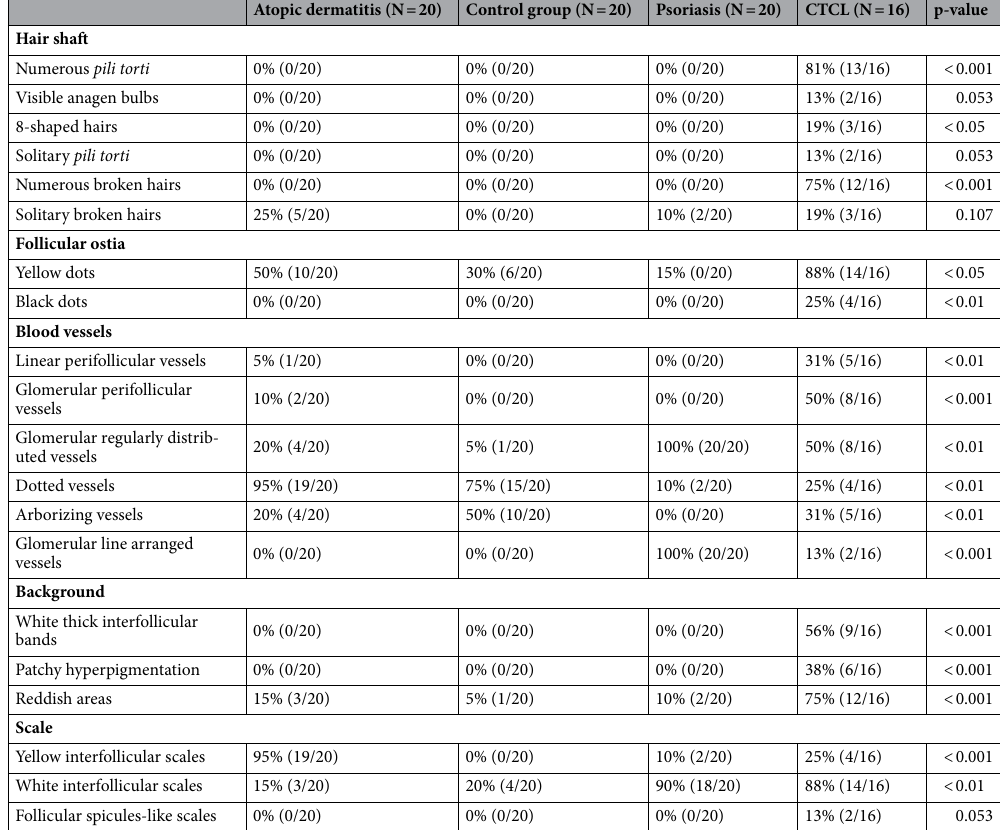
Table 1. Descriptive statistics among specific groups of patients: erythrodermic atopic dermatitis, control group, erythrodermic psoriasis, erythrodermic variants of cutaneous T-cell lymphoma (CTCL). Among those features only two do not perform any statistically significant differences for inter-group comparisons: visible anagen bulbs (p = 0.053) and single broken hairs (p > 0.1). For the other features further multiple comparison test was